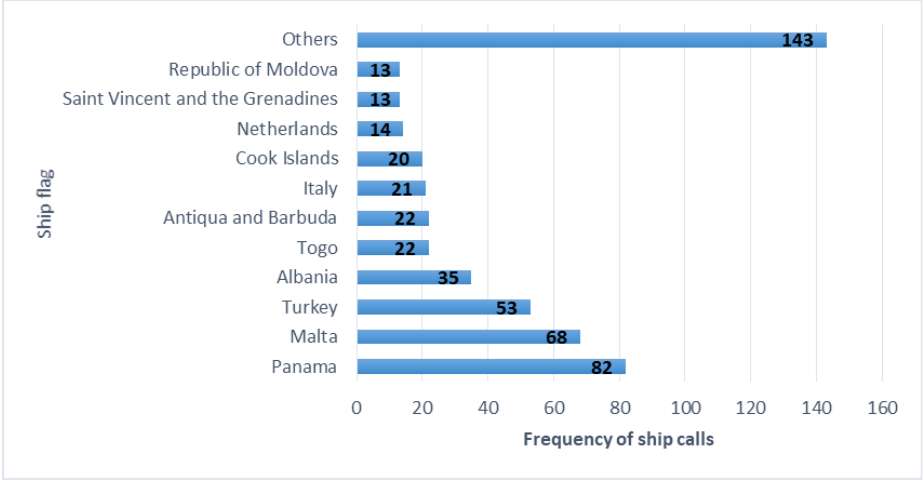
Figure A8. Frequency of BW discharging ships by ship flag.